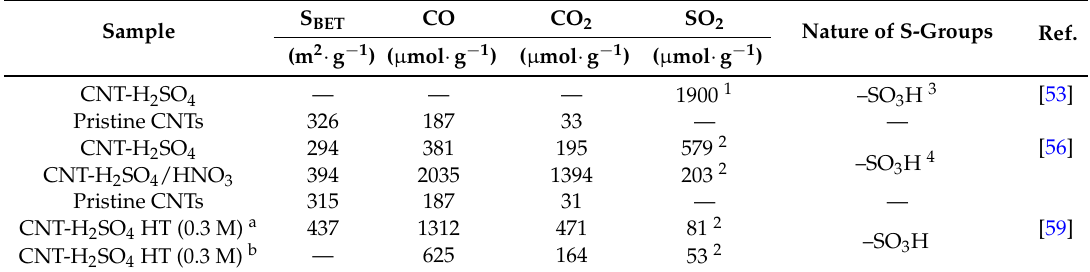
Table 3. Textural and chemical properties of S-doped CNT samples from the literature.